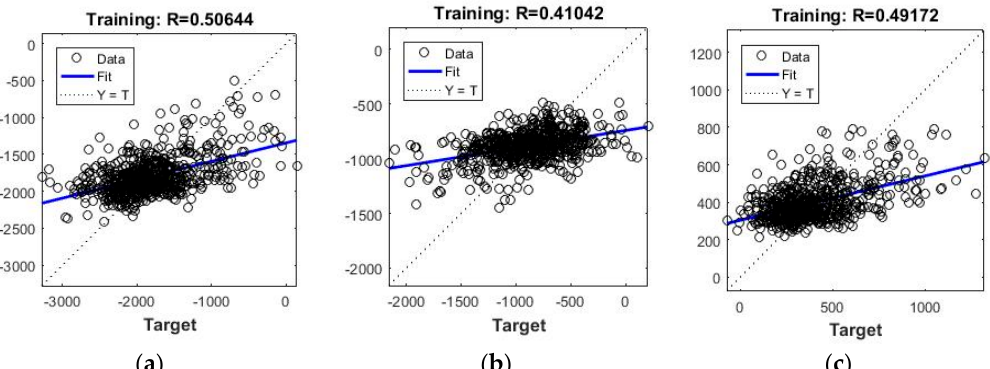
Figure 6. BNN two hidden layers fitting results based on the 85% of the samples: ( a ) Group of multispectral vegetation indices against GPR slice depth between 0.00–0.20 m; ( b ) Group of multispectral vegetation indices against GPR slice depth between 0.20–0.40 m; and ( c ) Group of multispectral vegetation indices against GPR slice depth between 0.40–0.60 m.